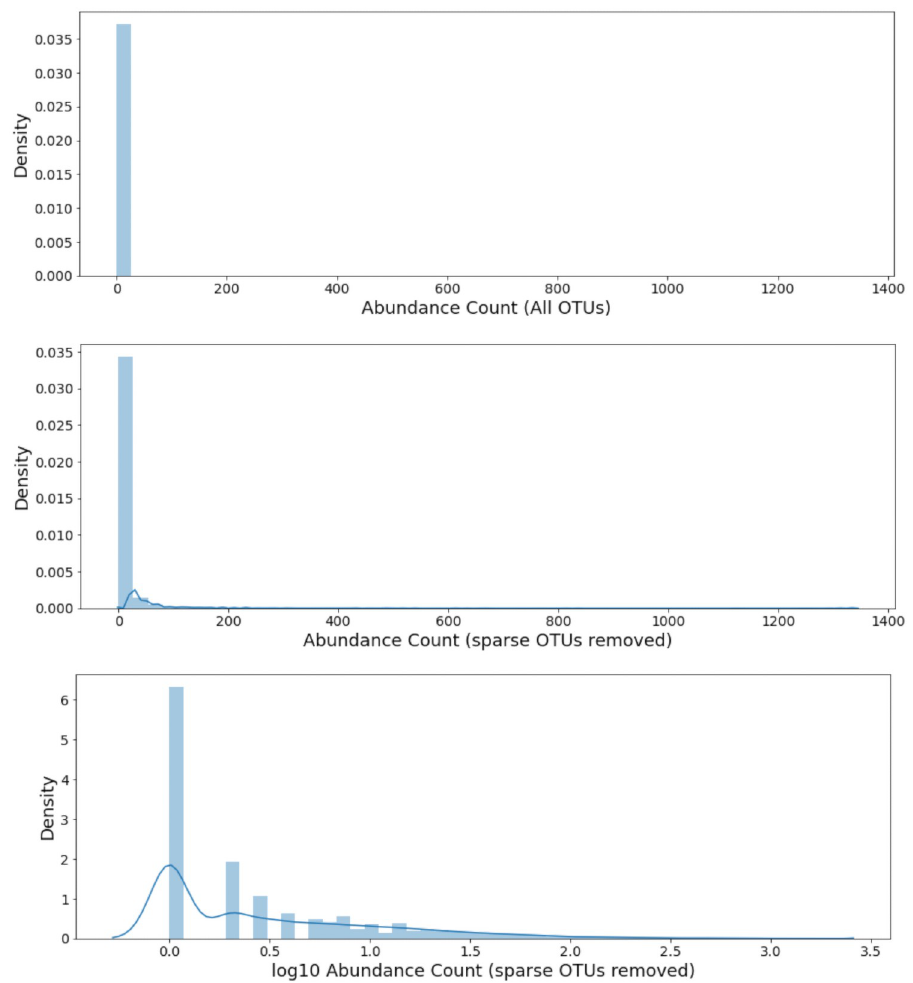
Fig 4. Species abundance counts after each pre-processing transformation. (Top) Distribution of counts from all 21721 species; the density is extremely skewed towards the low end. (Middle) Distribution of only the top 50 species by sum. (Bottom) Distribution of the top 50 species after a log 10 transformation. Rarer but higher-abundance species are now